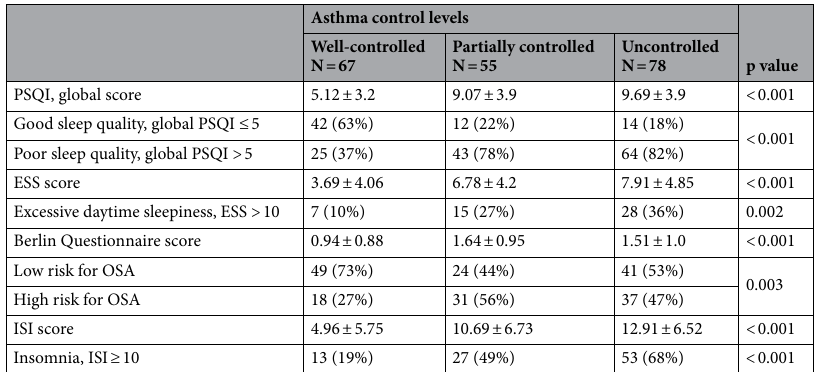
Table 2. Sleep quality, daytime sleepiness, and insomnia in patients with different levels of asthma control. PSQI Pittsburgh sleep quality index, ESS Epworth sleepiness scale, OSA obstructive sleep apnea, ISI insomnia severity index.